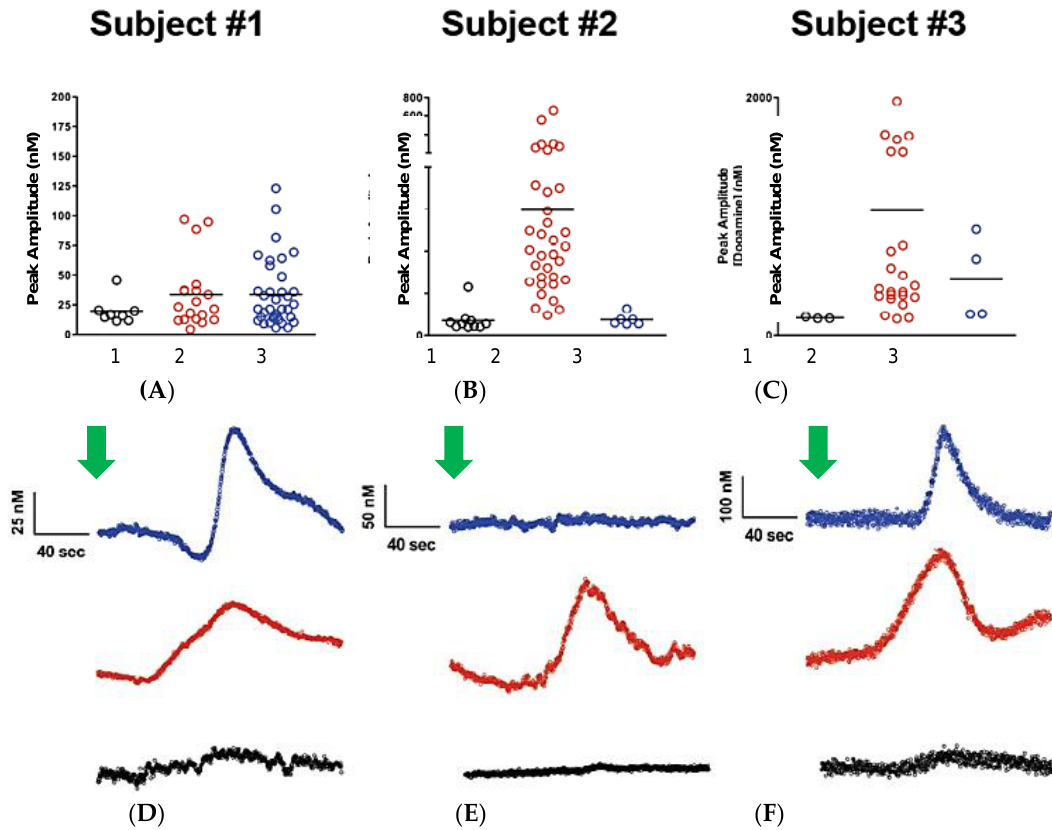
Figure 5. Upper plots ( A – C ) show the self-referenced dopamine peak amplitude at the 3 depths for subjects 1–3; bar is the average amplitude of the spikes in each region. Lower traces ( D – F ) are self-referenced DA concentration versus time plots for the three test subjects following administration of d-amphetamine. Green arrows indicate the time that the d-amphetamine was administered. Note the high signal-to- noise of these signals that are not filtered or averaged. Typical detection limits of these signals, based on a signal-to-noise of 3, typically ranged from 0.3 to 1 nanomolar, rivaling the recent report of Taylor et al., 2019 [51].